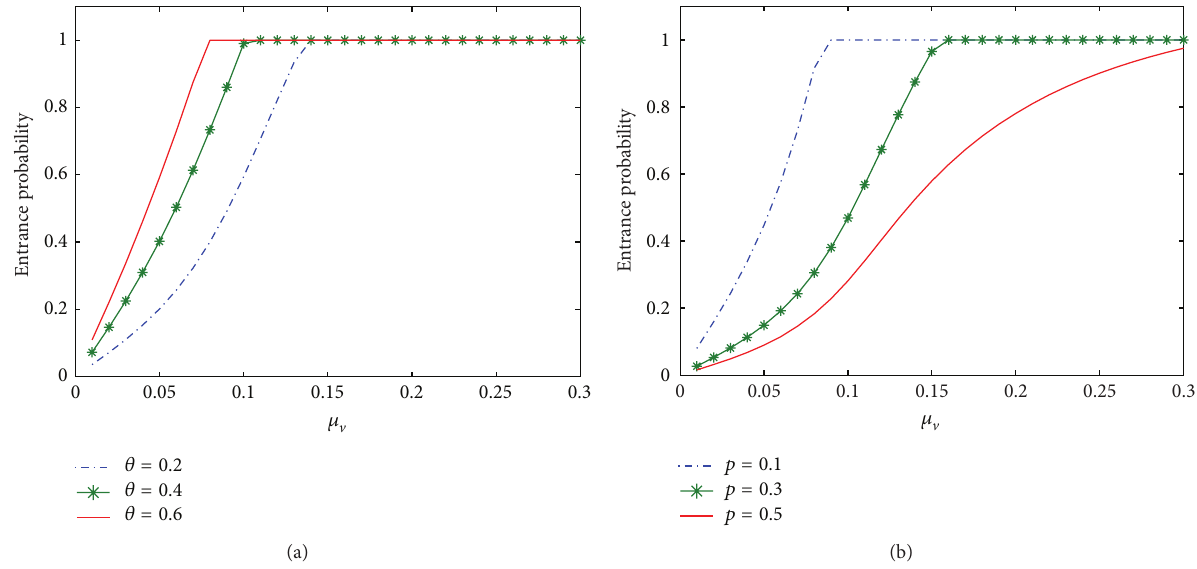
Figure 4: Equilibrium entrance probability for the fully unobservable model. Sensitivity with respect to (a) 𝜇 V , for 𝜇 𝑏 = 1 , 𝑝 = 0.5 , 𝐶 = 1 , 𝜇 = 0.6 , 𝐶 = 1 , 𝑅 = 10 , 𝜃 = 0.1 𝑅 = 10 ; (b) 𝜇 V , for 𝑏